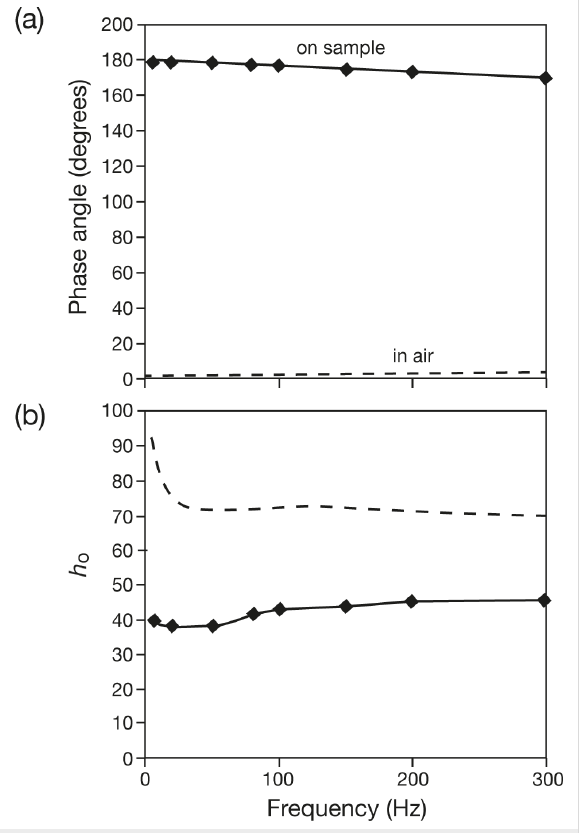
Figure 8: AFM tip modulation: (a) Phase shift and (b) amplitude in air (dashed line) and on sample (solid line).